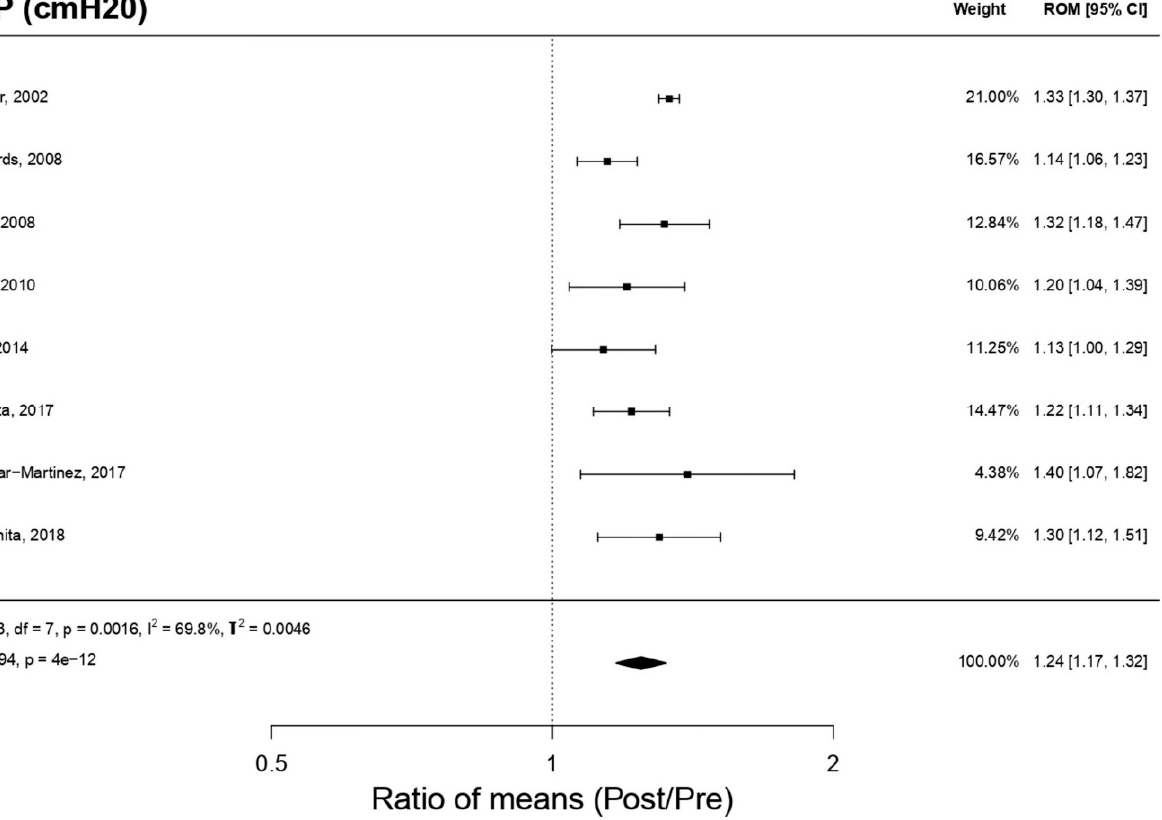
Figure 3. Funnel Plot meta-analysis results for Maximal Pressure Inspiratory.